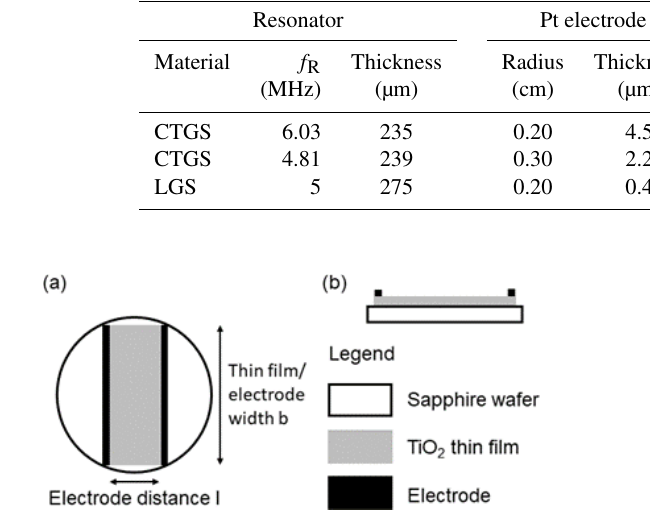
Figure 5. Schematic of the samples used for conductivity measure- ments of TiO 2 thin films. (a) Top view. (b) Side view.